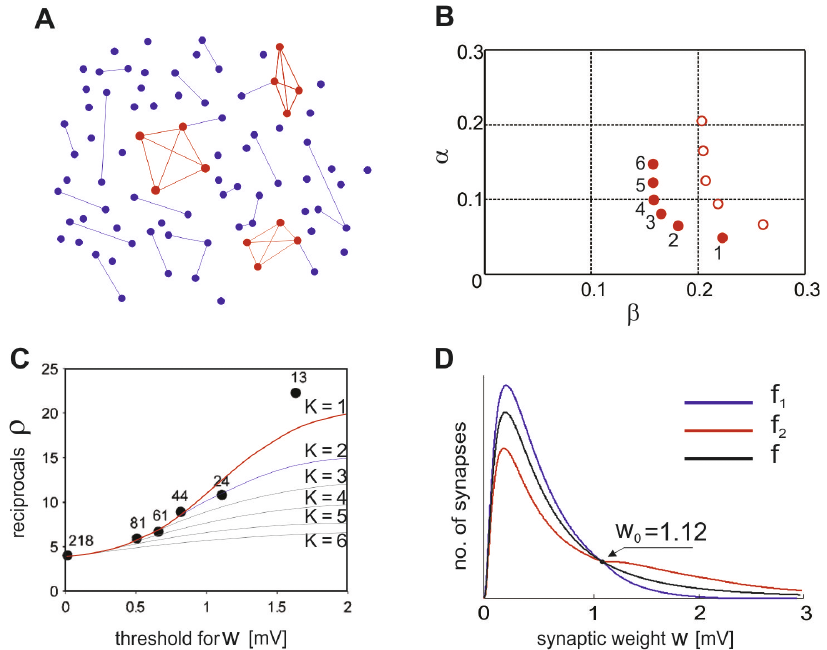
Figure 1. Structure and parameters of the model. A , Our NC model is schematically illustrated. The connection probability is higher in clusters ( c 2 ) than outside ( c 1 ). Connections inside and outside clusters are shown in red and blue, respectively. B , The parameter sets predicted by the model are depicted on the plane of a and b with filled circles. The numbers near the circles correspond to the values of K . Empty circles depict the sets obtained under the assumption of 10% connections loss in slice preparations. C , The experimentally observed threshold-dependence of the overrepresentation of reciprocal connections is fitted by models for different values of K . The best fit with K =1 is red, the first after best fit with K =2 is blue, the other fits are black. The number near each data point shows the number of the corresponding connections obtained by experiment. D , The probability densities of synaptic weights are shown for K =1: f 2 ( w ) stands for connections inside the cluster and f 1 ( w ) for all the other connections, and f ( w ) for all connections in the entire network. The two distributions have identical values, i.e., f 1 ( w 0 )= f 2 ( w 0 ), at the threshold value of w 0 =1.12 [mV].